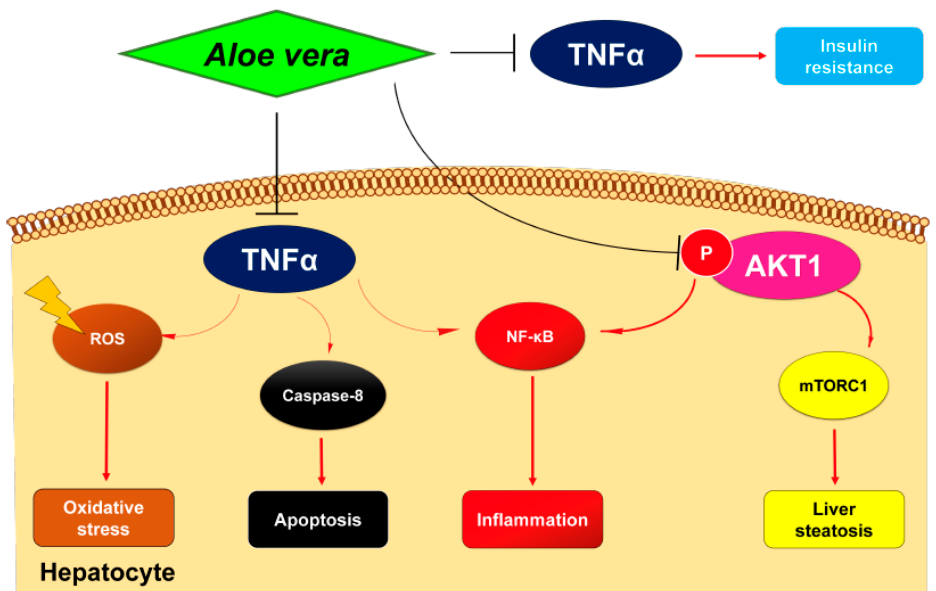
Figure 9. Schematic diagram of Aloe vera core targets for NASH treatment. AKT1, AKT serine/threonine kinase 1; mTORC1, mammalian target of rapamycin complex 1; NF- κ B, nuclear factor-kappa B (NF- κ B) ROS, reactive oxygen species; TNF α , tumor necrosis factor alpha.